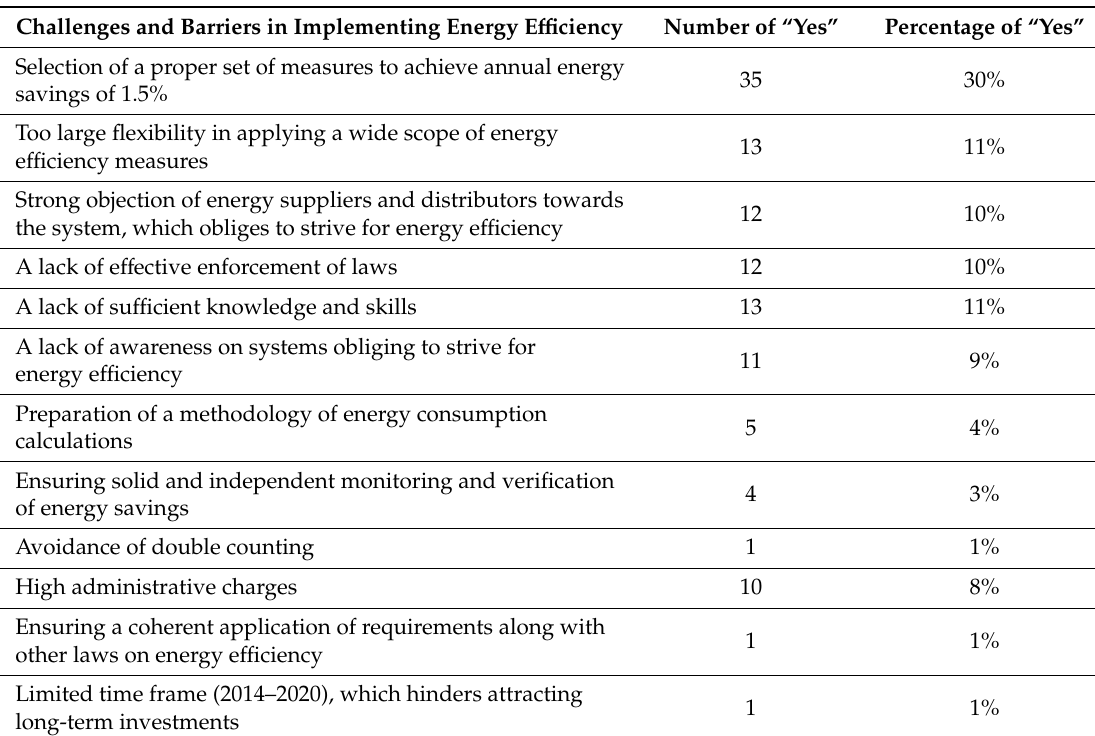
Table 2. Challenges and barriers of implementing energy e ffi ciency in